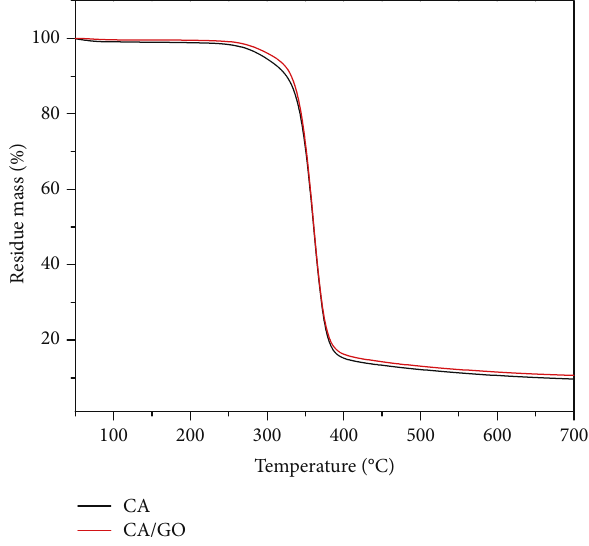
Figure 6: TGA Curves of CA nano fi ber and CA with GO nano fi ber at temperature between 50 ° C to 700 °